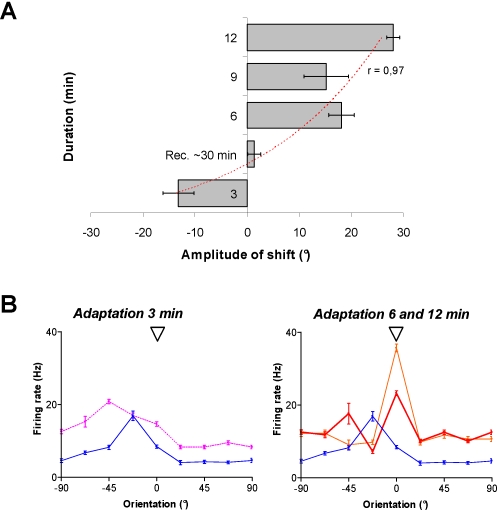
Influence of the adaptation duration on orientation tuning changes.The head arrow indicates the adapting oriented-stimulus (0°). A: Cells were adapted for 3, 6, 9 and 12 min to non-preferred oriented-stimulus (±22.5°–45.0° off the control optimal orientation). After 3 min, cells show repulsive shifts 88% (14/16) averaging 13.2°±3.0°. Following a recovery period of 30 min, cells were again adapted to the same stimulus for 6, 9 and 12 min. Cells displayed almost exclusively 96% (23/24) attractive shifts averaging 18.1°±2.4° and 15.2°±4.2°, for 6 and 9 min, respectively. Twelve minutes of adaptation produced larger attractive shifts of 28.3°±1.2°. B: Example of a cell displaying a repulsive shift of 22.5° after 3 min of adaptation (left column, dashed purple curve). Six minutes of continuous adaptation produces a significant increase of response at the adapting orientation 0° (t-test, p<0.0001) but the firing rate still remains high at the preferred orientation −45.0° induced by the previous 3 min adaptation. Twelve minutes of adaptation induces a clear attractive shift of 22.5°.